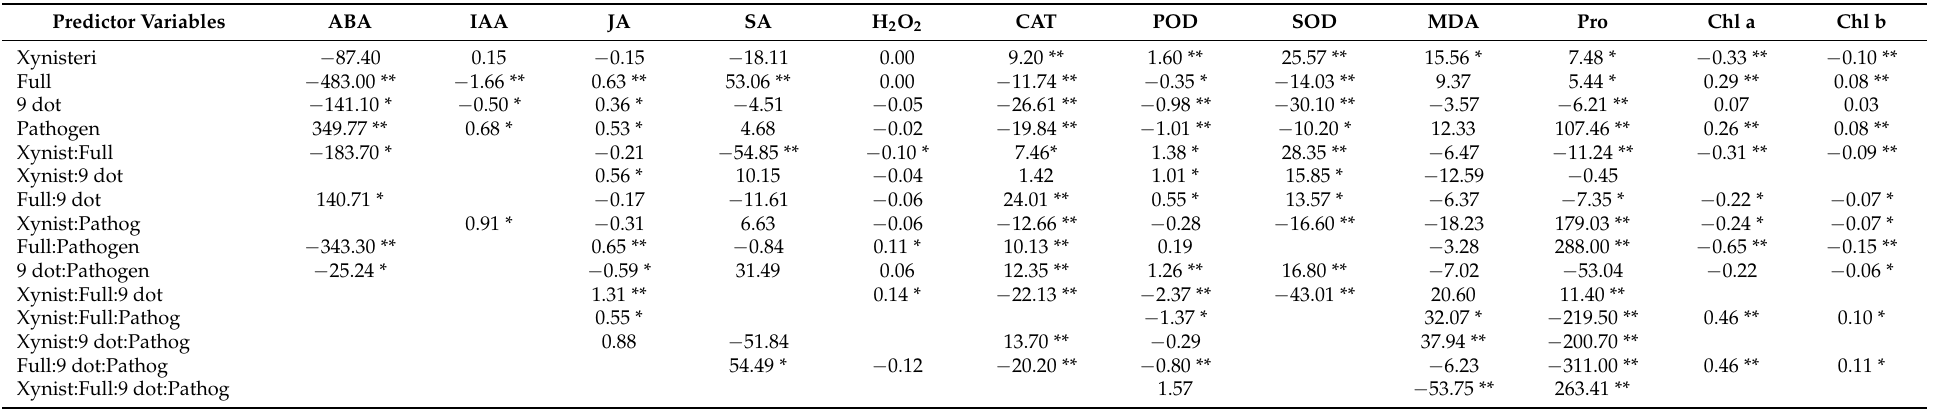
Table A2. Coefficient estimates for the different factors and interactions retained in the models after model selection. Interaction terms that were not important for the models were removed based on the AIC. The linear regression analyzes the interactions between the predictor variables: cultivar (Chardonnay or Xynisteri), irrigation (full or deficit), duration (of the irrigation treatment; 9 or 16 dot) and pathogen ( P. viticola or water inoculation). Coefficients are marked with a single asterisk if p -value < 15% and with a double asterisk if p -value < 5%. Predictor